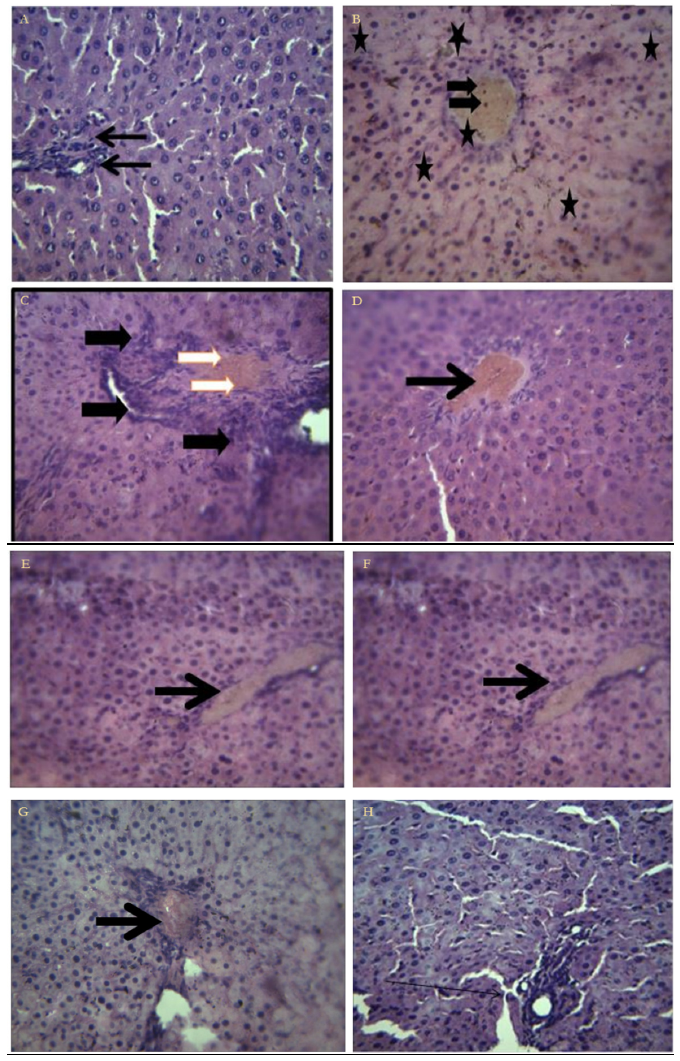
Figure 1. Cross section of liver A) Cross section of liver of that received 1 mL of distilled water (X400, H & E). Arrows show very mild periportal cellular infiltration by mononuclear cells though the hepatocytes; B) Cross section of liver ofacetaminophen-induced rat (X400, H & E). There was a mild diffuse hydropic degeneration of hepatocytes (stars), with mild periportal cellular infiltration (arrows) and visible lesions; C) Cross section of liver of acetaminophen-induced rat pre-administered 1 mL of 50 mg/kg body weight of silymarin (X400, H & E). There was a mild congestion of the portal vessels (white arrows), with mild periportal cellular infiltration by mononuclear cells (black arrows); D) Cross section of liver of acetaminophen-induced rat pre-administered 1 mL of 100 mg/kg body weight of fraction of C. papaya leaves (X400, H & E). Arrow shows mild congestion of the portal vessels with lesion. The hepatocytes showed visible lesions; E) Cross section of liver of acetaminophen-induced rat pre-administered 1 mL of 200 mg/kg body weight of fraction of C. papaya leaves (X400, H & E). Arrow shows visible lesions. There were normal arrangements of hepatocytes with visible lesions; F) Cross section of liver of acetaminophen-induced rat pre- administered 1 mL of 400 mg/kg body weight of fraction of C. papaya leaves (X400, H & E). Arrow shows visible lesions. There were normal arrangements of hepatocytes with visible lesions; G) Cross section of liver ofacetaminophen-induced rat pre-administered 1 mL of 600mg/kg body weight of fraction of C. papaya leaves (X400, H & E). Arrow shows visible lesions. Very mild periportal cellular infiltrations by mononuclear cells were visible though the hepatocytes were normal; H) Cross section of liver of rat administered 1 mL of 600mg/kg body weight of fraction of C. papaya leaves (X400, H & E). Arrow shows very mild lesions with no hepatocyte degeneration. There was very mild periportal cellular infiltration by mononuclear